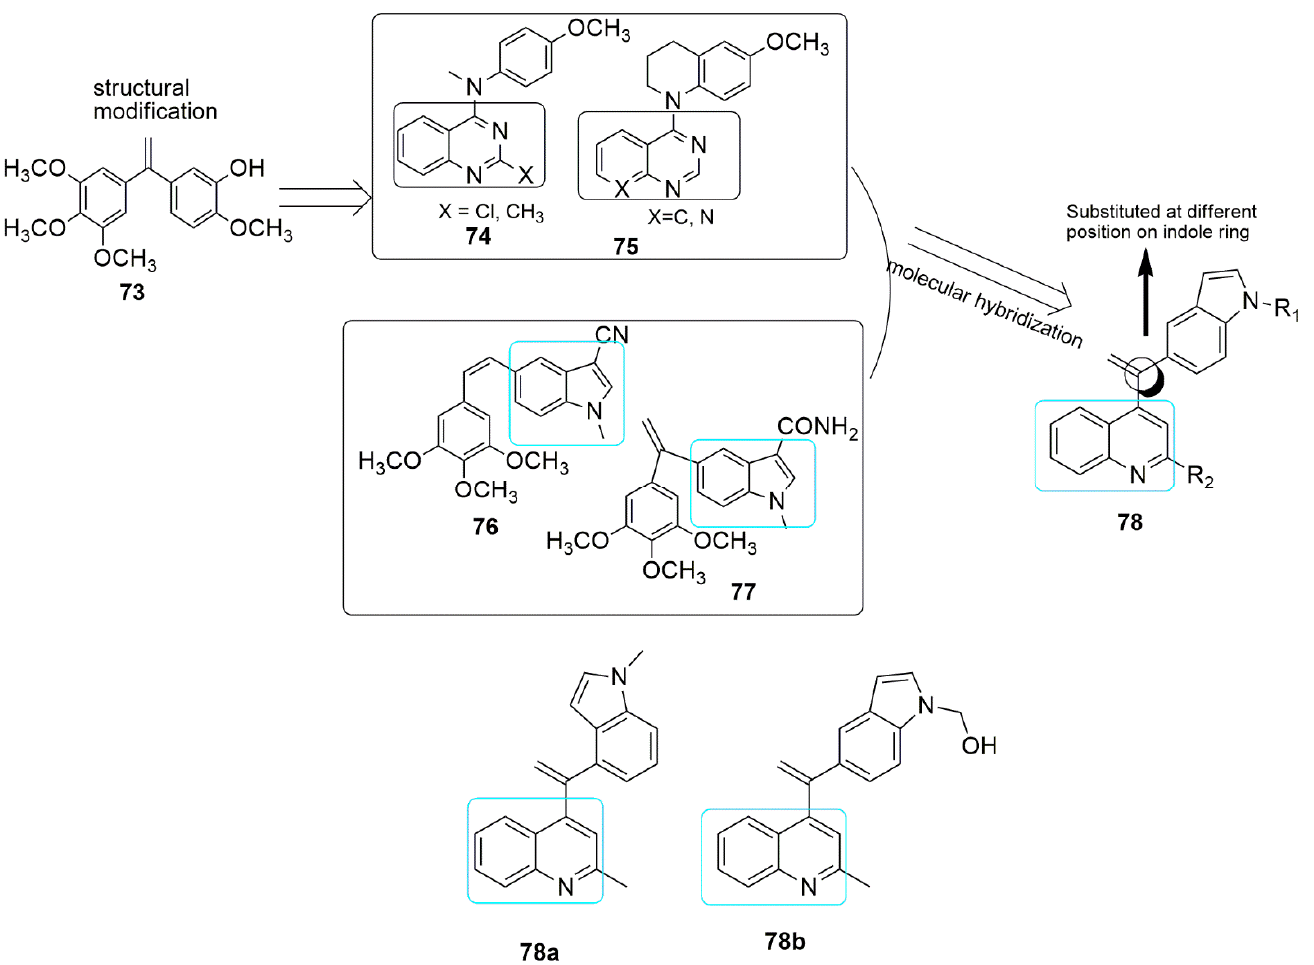
Figure 22. Chemical structures of quinoline evaluated against different panel of cancer cell lines. Mirzaei et al. combined the pharmacophores of 2-aryltrimethoxyquinoline 79 and chalcone 80 to design and synthesize new promising anti-cancer agents and tubulin poly- merization inhibitors [67]. Four human cancer cell lines including A-2780 (human ovarian carcinoma), A-2780/RCIS (cisplatin-resistant human ovarian carcinoma), MCF-7 (human breast cancer cells), and MCF-7/MX (mitoxantrone resistant human breast cancer cells), and normal Huvec cell line (human umbilical vein en-dothelial cells) were employed in the MTT assay. Among the forty-eight compounds synthesized and evaluated against the four panels of cancer cell lines, compound 81a bearing dimethoxyphenyl group (R 1 = R 2 = OCH 3 ) on ring C and 4-nitrophenyl (R 6 =NO 2 ) on ring D showed excellent cytotoxic effects against A- 2780, A-2780/RCIS, MCF-7, and MCF-7/MX cancer cells (see Table 5). At the same time, 81b (R 1 = R 2 = R 3 = OCH 3 , R 6 = NO 2 ) and 81c (R 1 = R 2 = R 3 = OCH 3, R 6 = R 7 = OCH 3 ) showed superior cytotoxic activity on A-2780 cancer cells compared to other derivatives. Mean- while, trimethoxyphenyl (ring C) substitution with dimethoxy phenyl, 2-methoxyphenol, or 4-methoxy phenyl diminishes the cytotoxic activity. In addition, the substitution of the methoxy group of the ring C with bulky groups, namely phenoxy (R 6 = OPh) or benzoyl at either the R 4 or R 7 position, reduced the cytotoxic effect. Notably, substitutions on ring D enhanced the cytotoxicity activity; this includes insertion of the nitro group at the para position of ring D. Compounds 81a and 81c inhibited tubulin polymerization by 45.62% and 40% at a concentration of 20 µ M, respectively. 81c arrested the cells in the G2/M phase, reduced cells accumulation in the G2/M phase, and enhanced the number of apoptotic cells (cells in the sub-G1 phase) (see Figure 23, Table